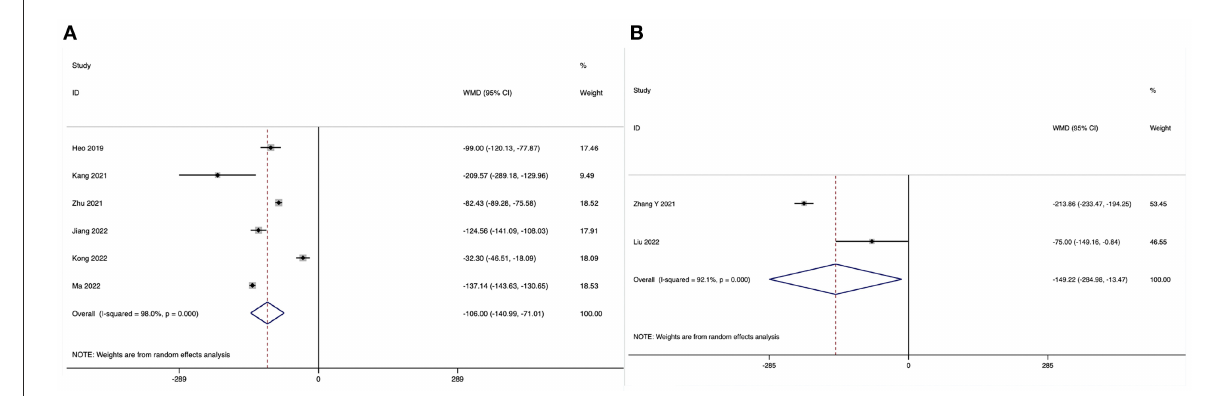
FIGURE2 Forest plot of the estimated blood loss. (A) ULIF vs. MI-TLIF; (B) ULIF vs. PLIF.